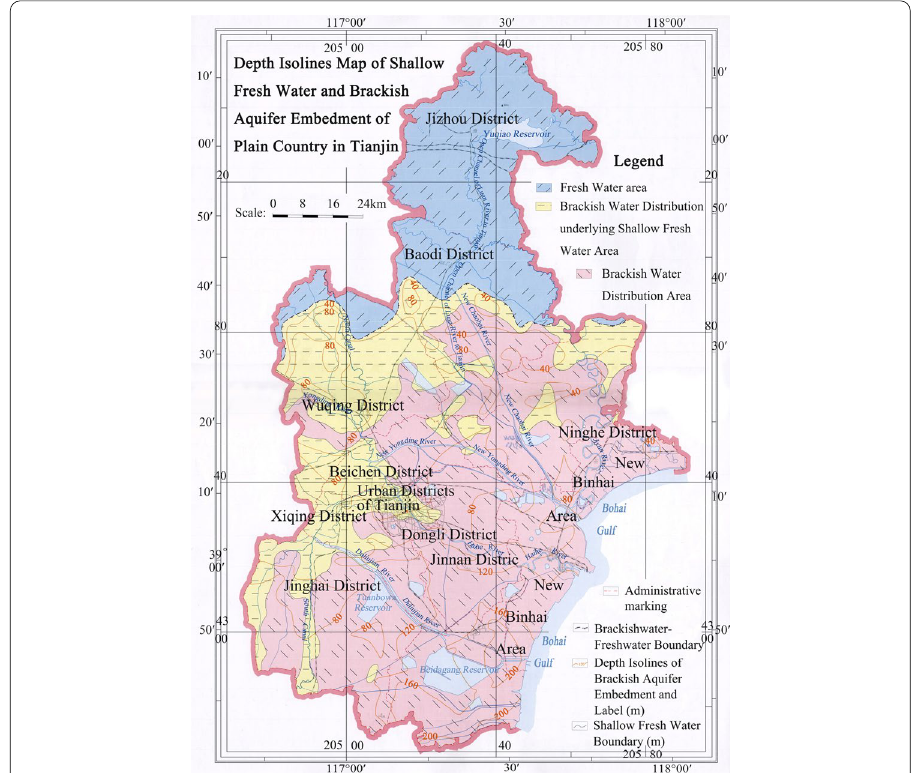
Fig. 1 Depth isolines map of shallow aquifer of plain country in Tianjin, China (Tianjin Bureau of Geology and Mineral Exploration and Development